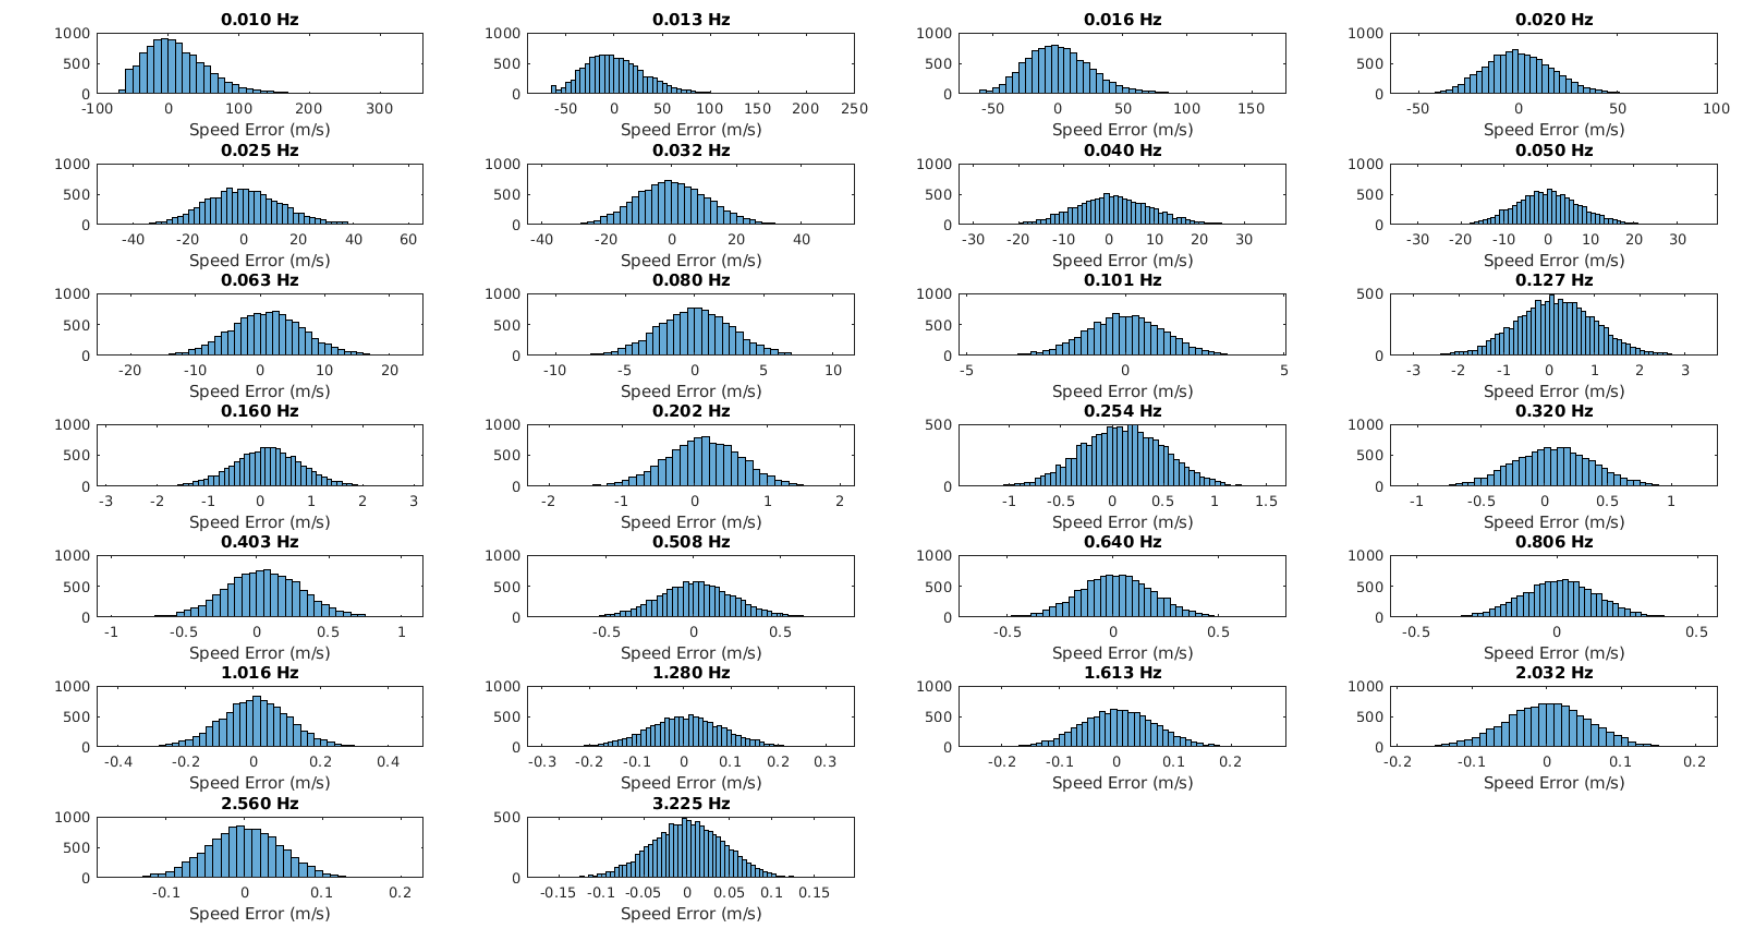
Figure A4. Trace velocity error (bias), SNR = 20 dB, M = 10 4